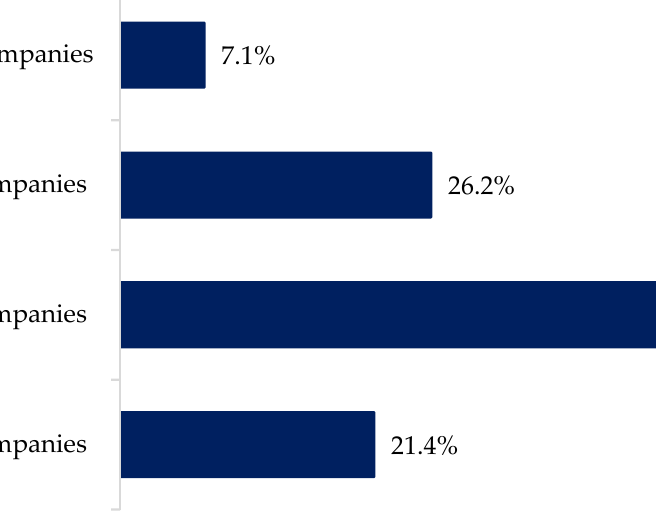
Figure 3. With how many people, institutions, or companies’ farmers are sharing their data.